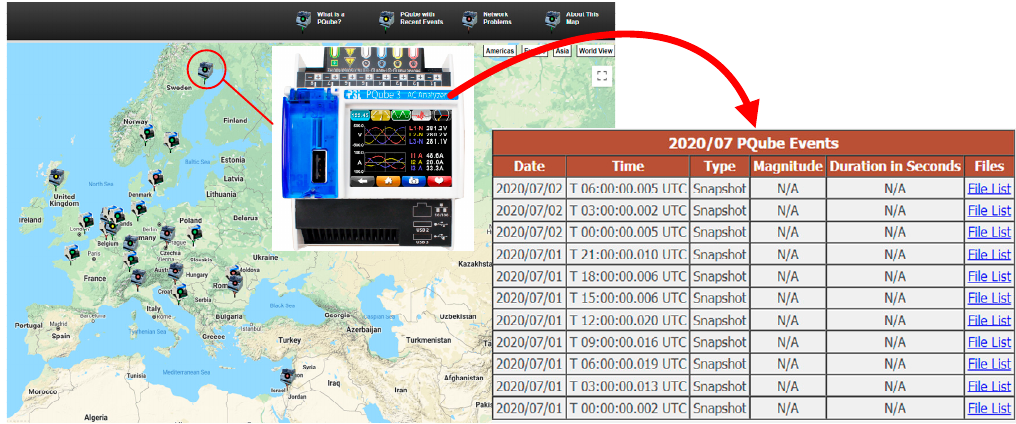
Figure 21. A cloud-based map of PQubes installed some locations in Europe [44].